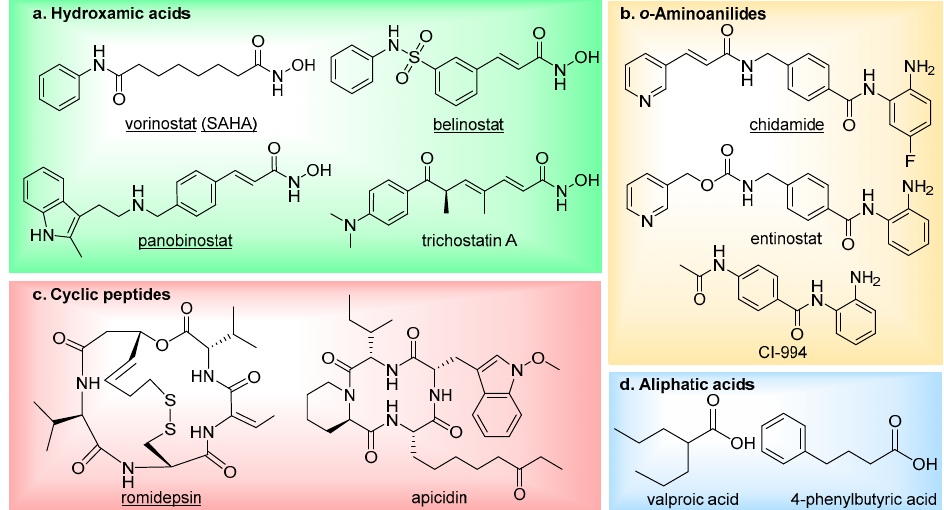
Figure 2. The main four classes of HDAC inhibitors, including FDA-approved drugs (underlined). To date, five HDAC inhibitors have been approved for cancer treatment-vorinostat and romidepsin to treat refractory cutaneous T-cell lymphoma [22,23], panobinostat for patients with multiple myeloma [24], plus belinostat and chidamide for the treatment of relapsed or refractory peripheral T-cell lymphoma [25,26]. These and additional HDAC inhibitors have also entered clinical trials for the treatment of other types of cancer [27] (NCT00138203, NCT00077194, NCT00451035, NCT00828854, NCT02236195), as well as non-oncology indications such as neurodegenerative diseases (NCT02124083, NCT00212316) and epilepsy (NCT03894826). Although first generation